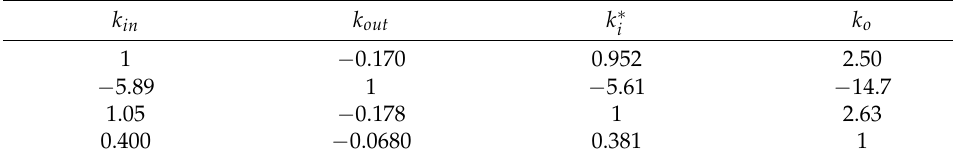
Table 6. OGs possible combinations with ICE working at 1400 rpm and 2080 Nm. k in